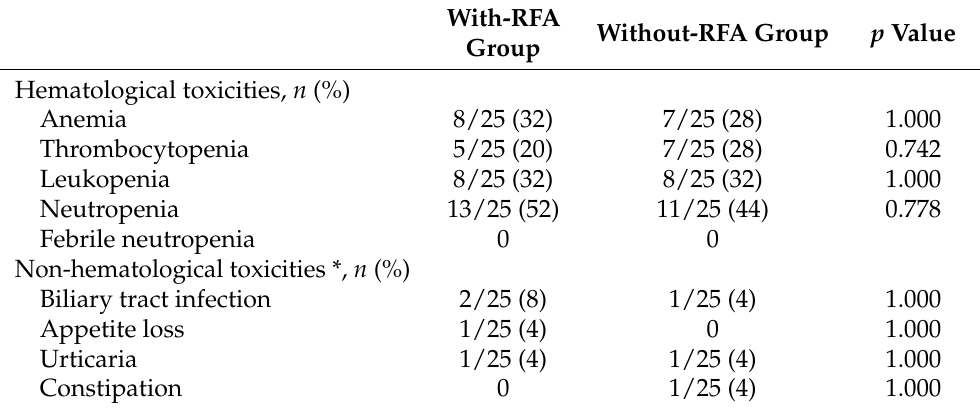
Table 4. Grade 3 or higher adverse